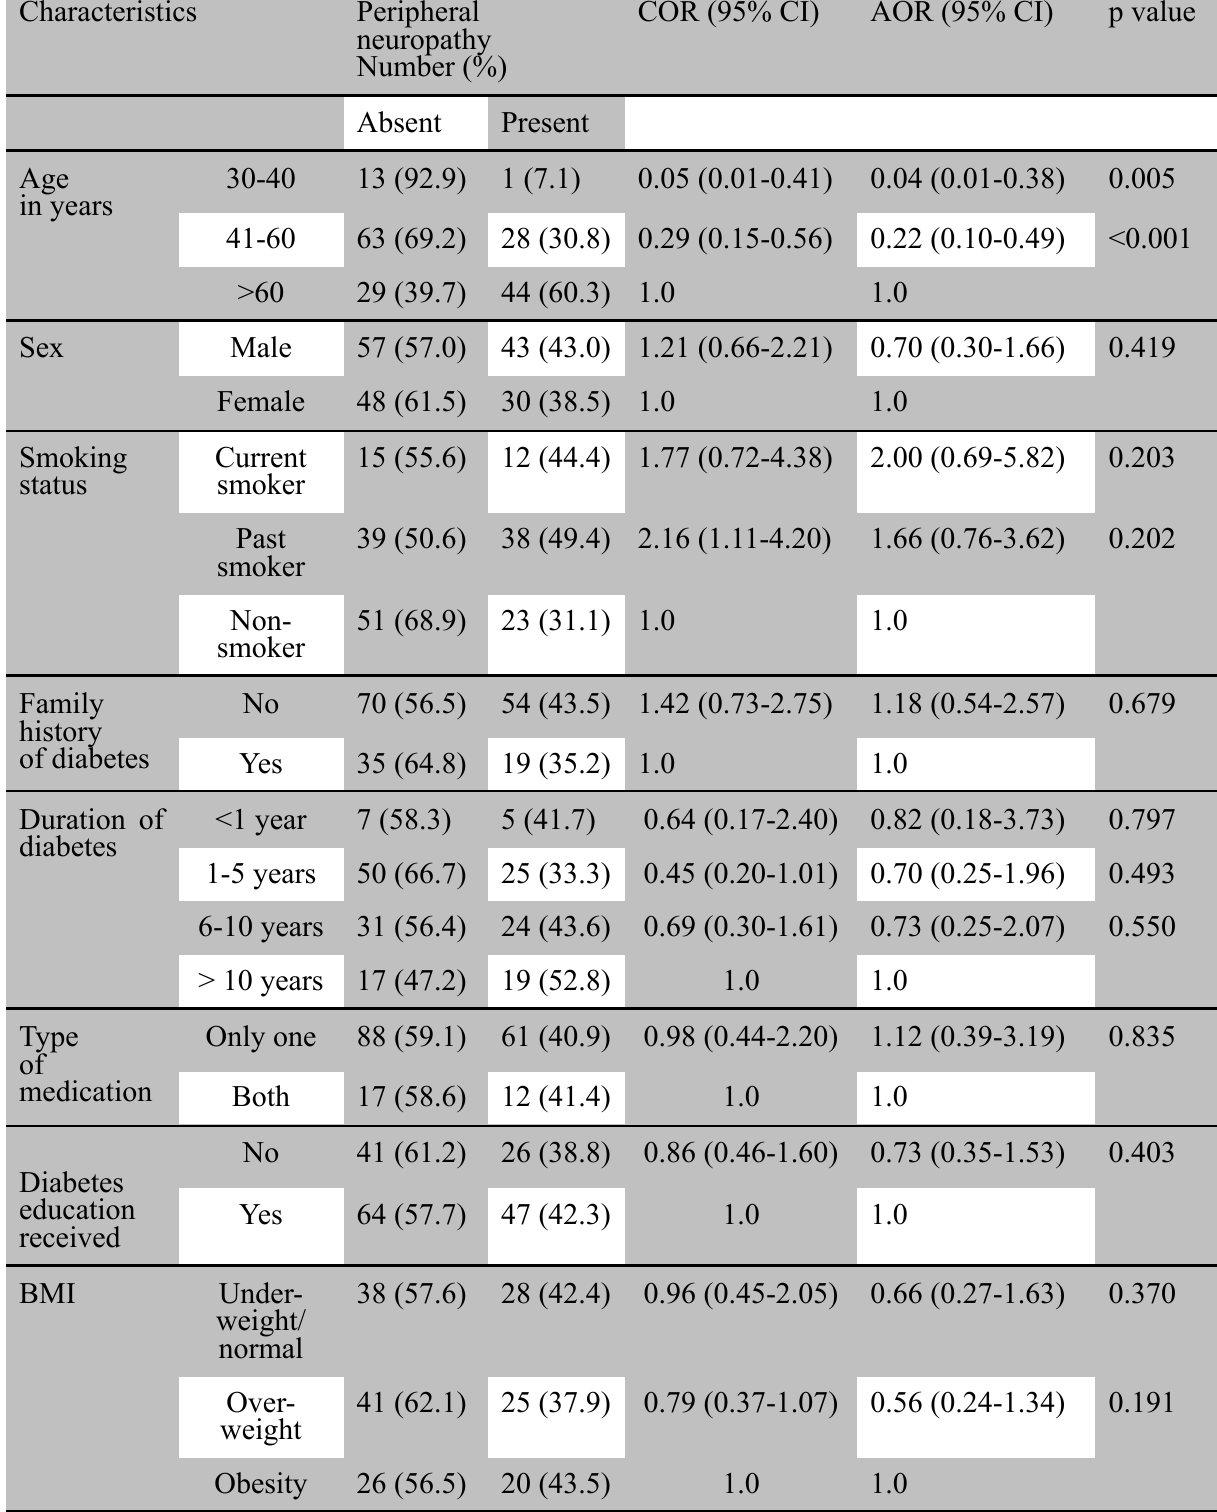
Table 4: Factors associated with peripheral neuropathy among the participants (n=178)